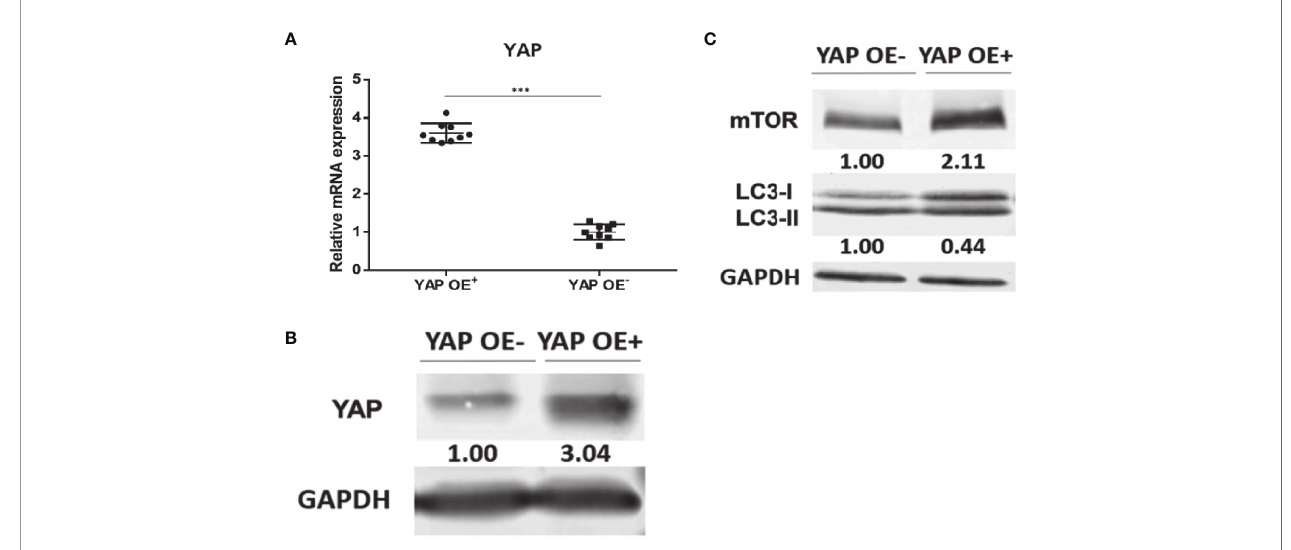
FIGURE 4 | Overexpression of YAP in the eutopic ESCs of endometriosis inhibited autophagy level. The qPCR showed that the expression of YAP mRNA was increased signi fi cantly (3.60 ± 0.16 vs. 1.00 ± 0.21; P = 0.0006) after transfection with YAP-overexpression plasmid in the eutopic ESCs compared with controls (the eutopic ESCs transfected with the empty plasmid) (A) . Western blotting revealed that we obtained a high OE ef fi ciency at the YAP protein level (3.04 vs. 1.00) (B) . The expression of mTOR protein (2.11 vs. 1.00) was signi fi cantly increased in the eutopic ESCs compared with controls following YAP-OE. By contrast, there was a